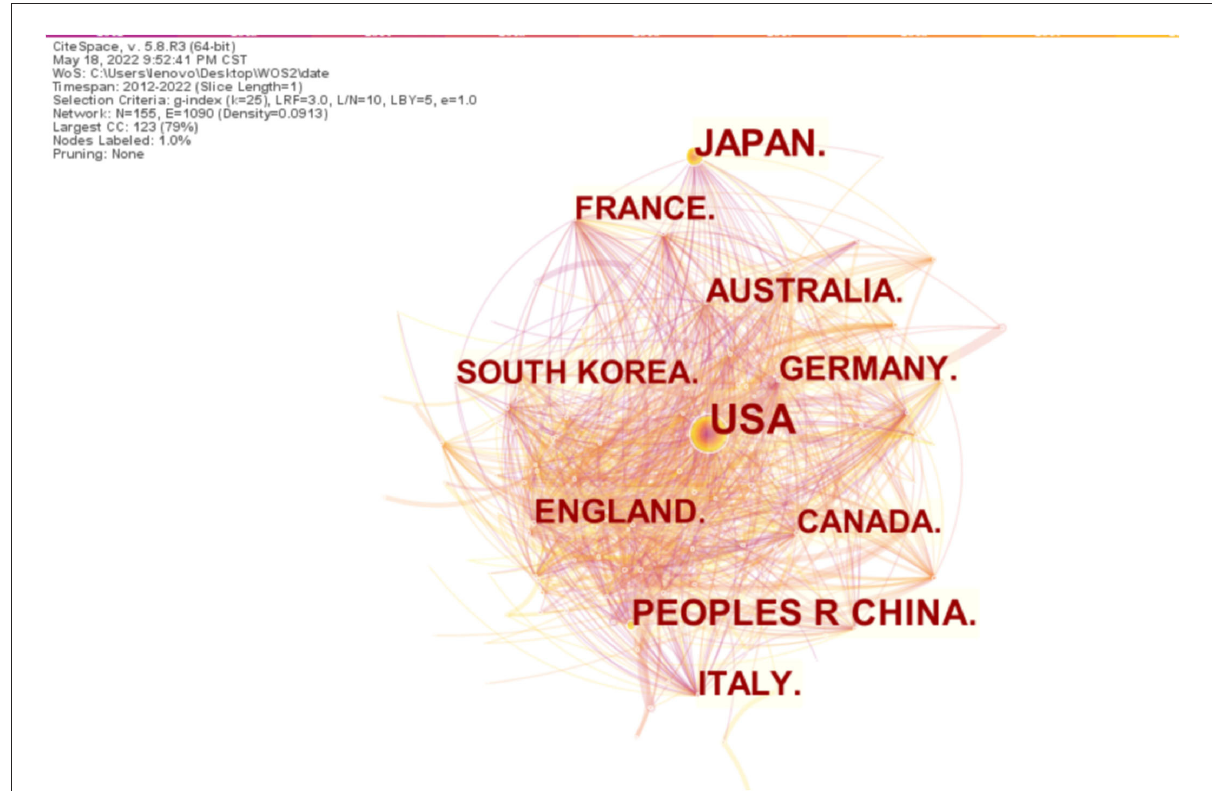
FIGURE4 Map of institutions distribution and cooperative relations on dysphagia from 2012 to 2022. The larger the circle, the more articles are published in that country. The shorter the distance between the two circles, the more the cooperation between the countries.